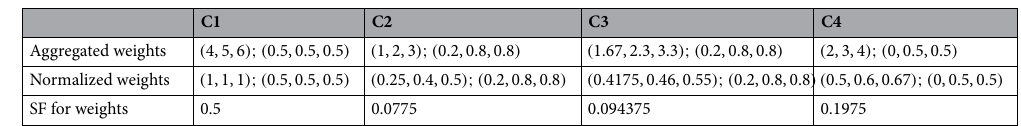
Table 4. The aggregated and normalized values of weights.